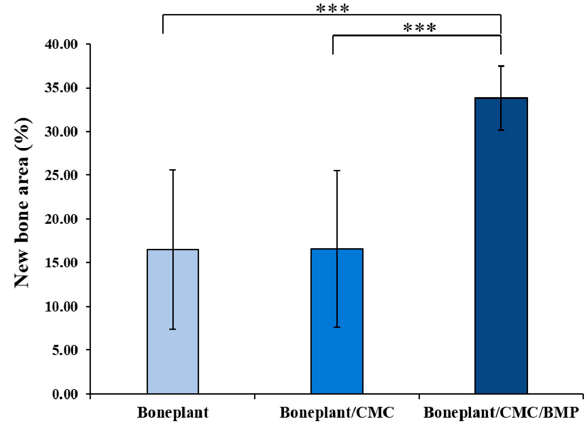
Figure 8. New histometrical bone area percentages of each group. The symbol *** indicates statistical significance ( P < 0.001).